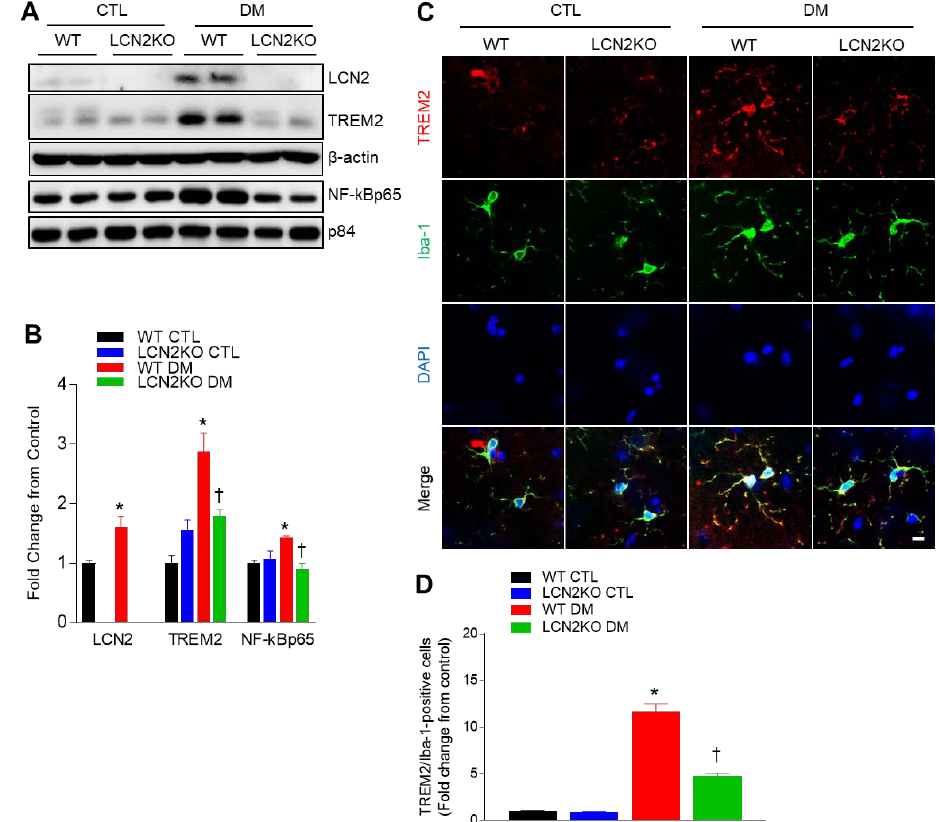
Figure 4. Effects of LCN2 deletion on microglial activation and hippocampal TREM2 expression in HFD/STZ-induced diabetic mice : ( A , B ) Western blot analysis and quantification of LCN2, TREM2, and NF- κBp65 in the hippocampus ; β -actin and p84 were used as loading controls for total protein and nuclear protein, respectively; ( C ) representative immunofluorescence images of TREM2 (red) and Iba-1 (green) in hippocampal sections; DAPI (blue) was used to stain nuclei; scale bar = 10 µm; ( D ) quantification of co-localized TREM2 and Iba-1-immunostained cells in the images. CTL: control; DM: diabetic mice. Data are presented as the mean ± SEM. The indicated p -values represent a two-way ANOVA, followed by Tukey’s post hoc test. * p < 0.05 vs. WT CTL. † p < 0.05 vs. WT DM.